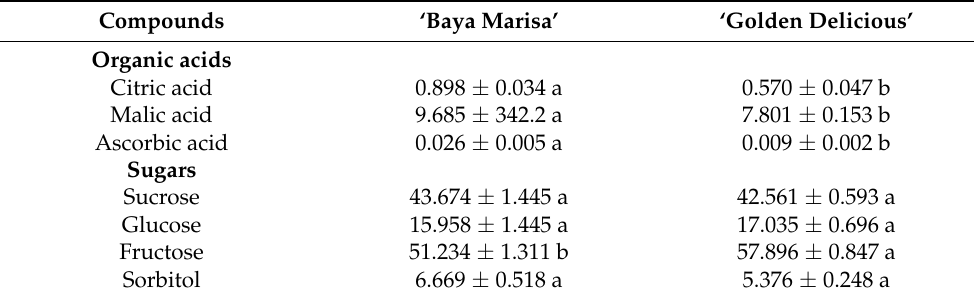
Table 1. Individual organic acids and sugars (mean ± SE, in g/kg FW) in fruits of red-fleshed ‘Baya Marisa’ and white-fleshed ‘Golden Delicious’. Compounds ‘Baya Marisa’ ‘Golden Delicious’ Organic acids Citric acid 0.898 ± 0.034 a Malic acid Ascorbic acid Sugars